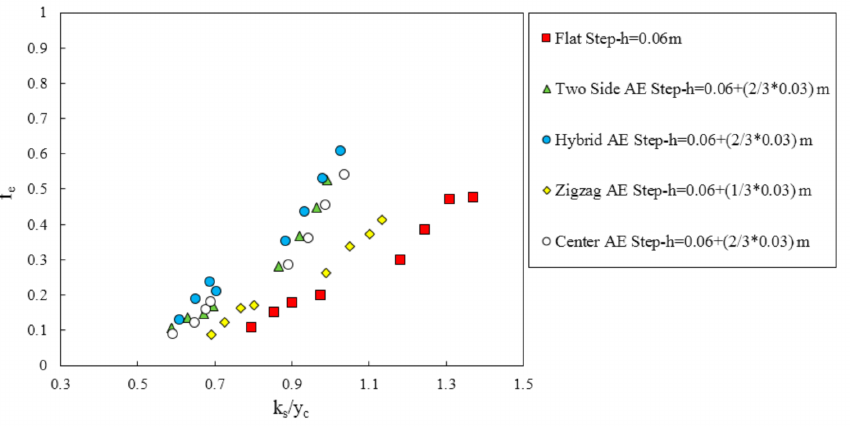
Figure 19. Darcy friction factors of stepped spillways with appendance elements on step versus (k s /y c ).